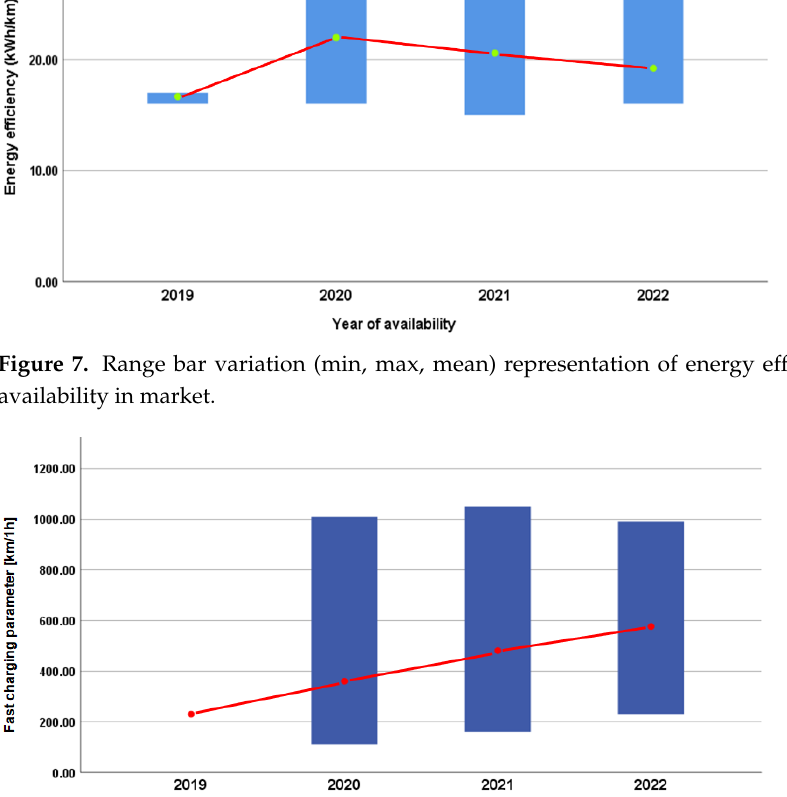
Figure 8. Range bar variation (min, max, mean) representation of fast charging speed vs. year of availability in market.